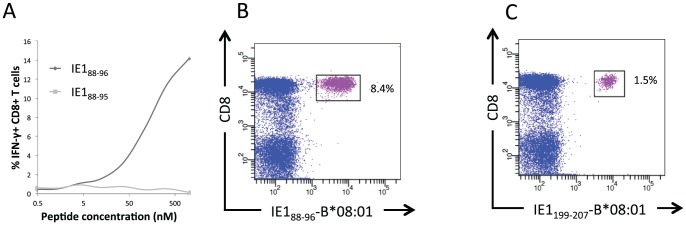
Donor 33 - CD8+ T cell epitope validation.CD8+ T cell responses were detected against the 15mers IE186–110 and IE1196–210. In IE186–110 two B*08:01 binding optimal peptides, IE188–95 and IE188–96, were predicted, while in IE1196–210 one B*08:01-restricted optimal peptide IE1198–207, was predicted. A) ICS analysis of predicted optimal peptides: Chart showing IFN-γ responses following restimulation of in vitro cultured PBMCs with graded doses of IE188–95 and IE188–96. B) Optimal epitope and HLA class I restriction validated by ex vivo peptide-HLA class I tetramer staining with the IE188–96-HLA-B*08:01 tetramer. C) Optimal epitope and HLA class I restriction validated by ex vivo peptide-HLA class I tetramer staining with the IE1199–207-HLA-B*08:01 tetramer. The plots show gated CD3+ T cells; frequencies of tetramer-positive CD8+ T cells (boxed-in and pink) are indicated.